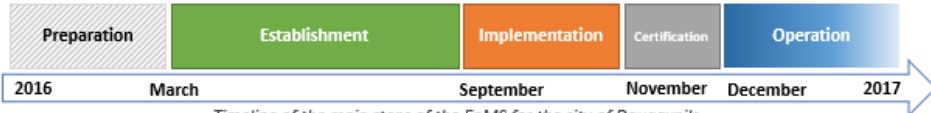
Fig. 2. Main steps of the EnMS implementation process [40].